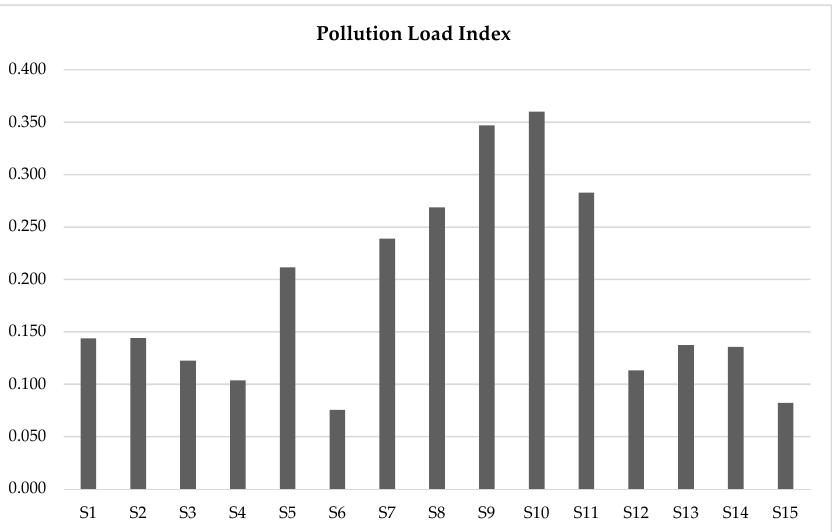
Figure 5. Pollution Load Index values of sampling sites at Surma River .